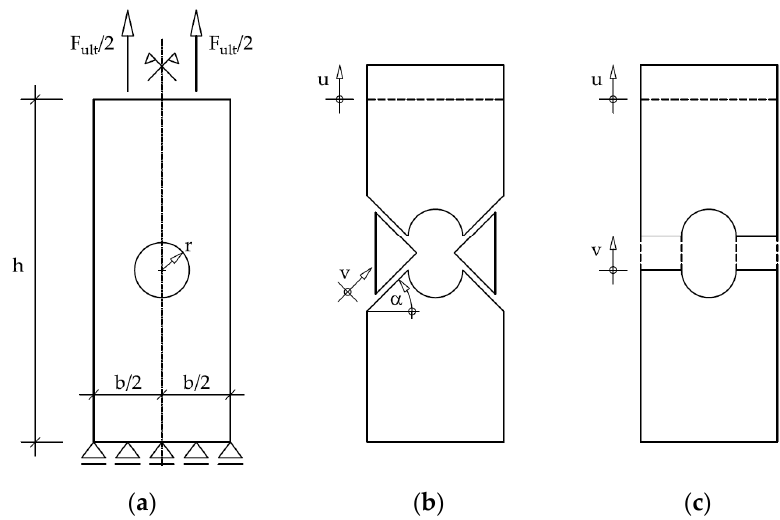
( c ) Figure 5. Failure mechanisms (equivalent plastic strain) from a finite element analysis (FEA) for the tensile specimen: ( a ) Mesh; ( b ) yield surface according to the T RESCA criterion was used; ( c ) yield surface according to the M ISES criterion was used.